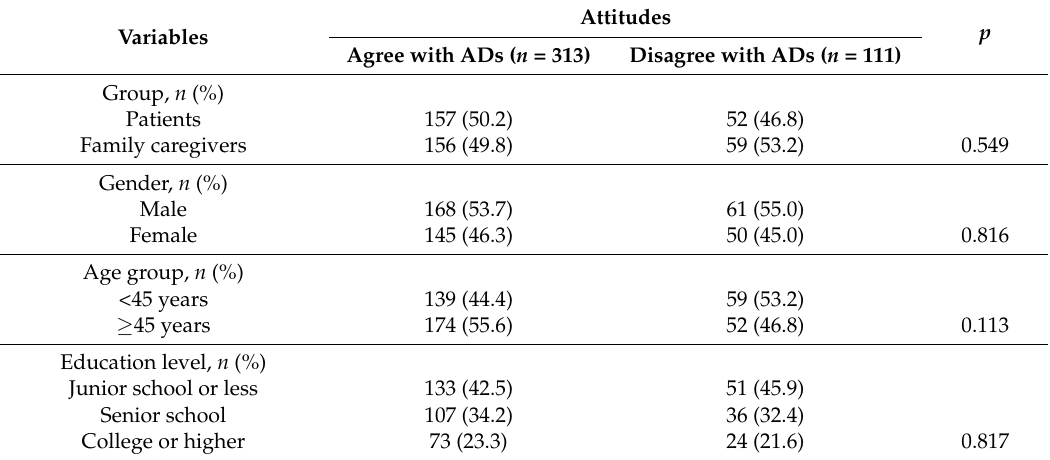
Table 3. Characteristics associated with participants’ attitudes toward